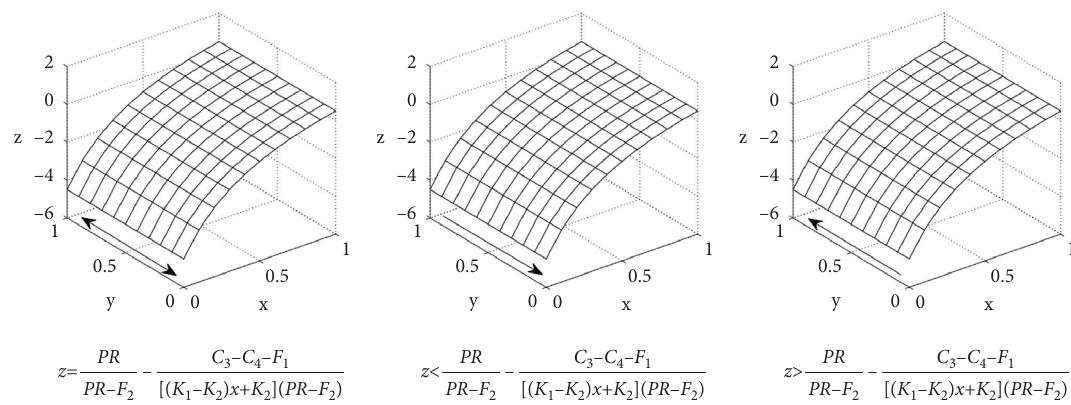
Figure 5: Te evolutionary process of